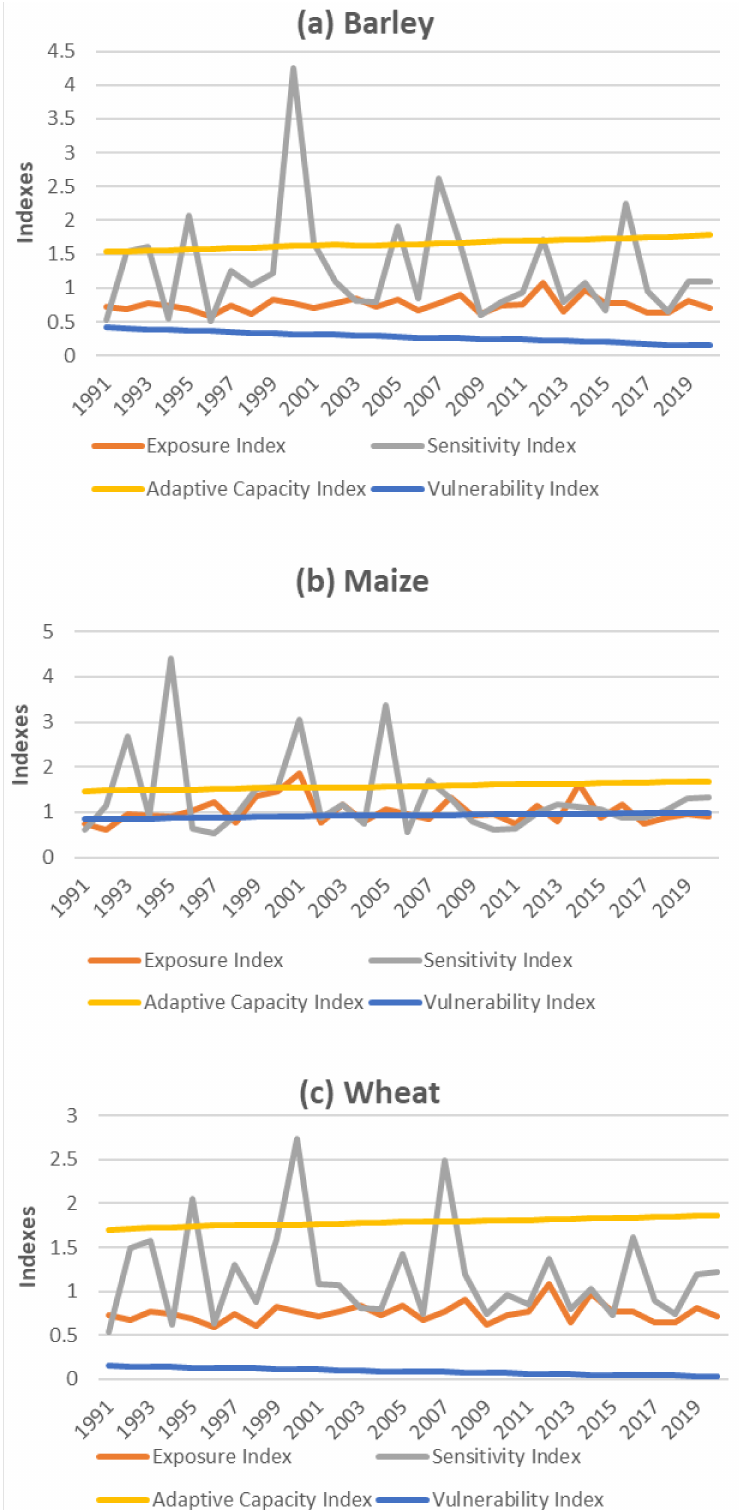
Figure 7. Temporal variations of vulnerability indexes for ( a ) barley, ( b ) maize, and ( c ) wheat at the national